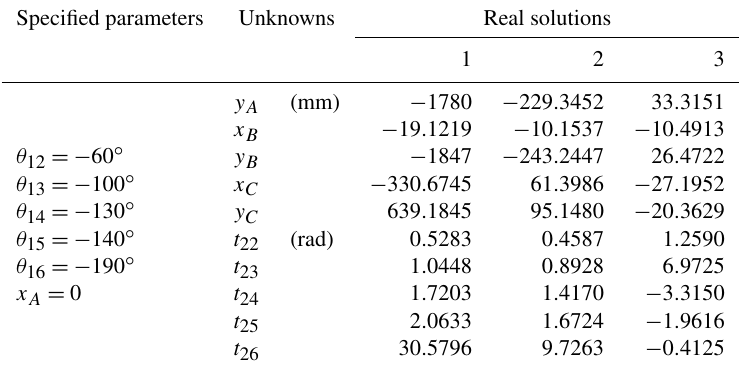
Table A2. Specified parameters and real